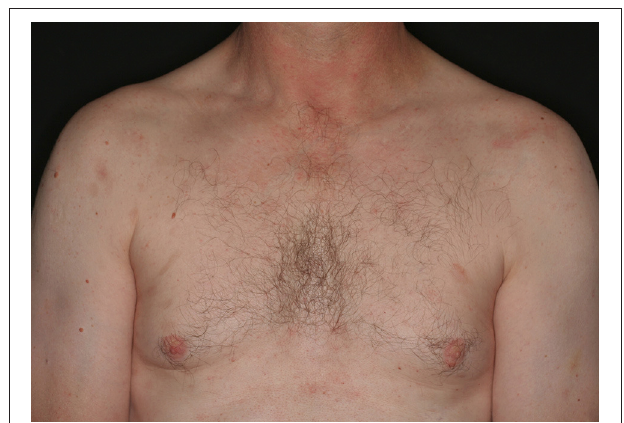
FIGURE 2 | Clinical picture eight months after initial rituximab